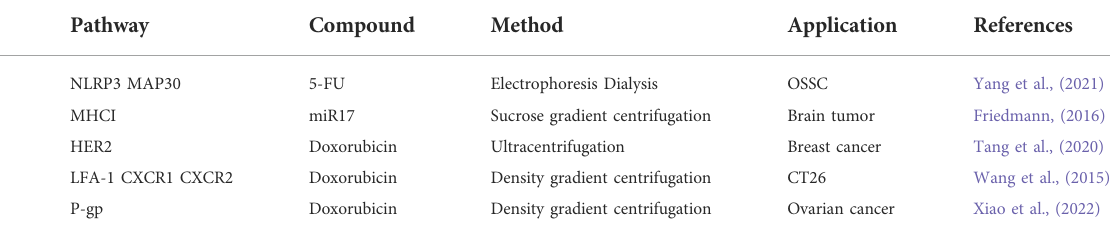
TABLE 2 Exosomes as drug carriers to deliver different